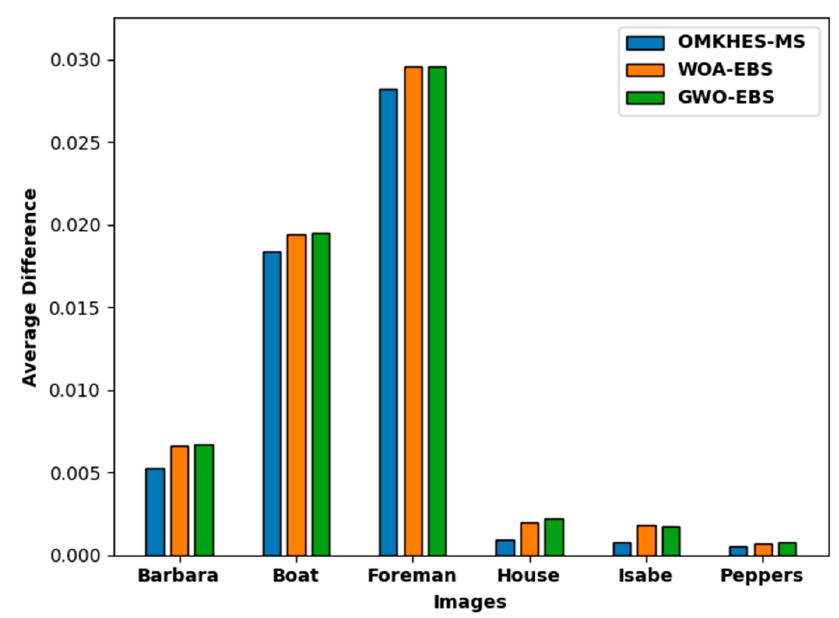
Figure 10. Comparative AD analysis of OMKHES-MS technique with existing models.